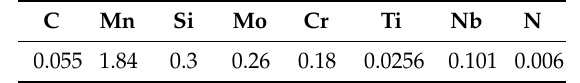
Table 1. Composition in wt.% of the studied material.